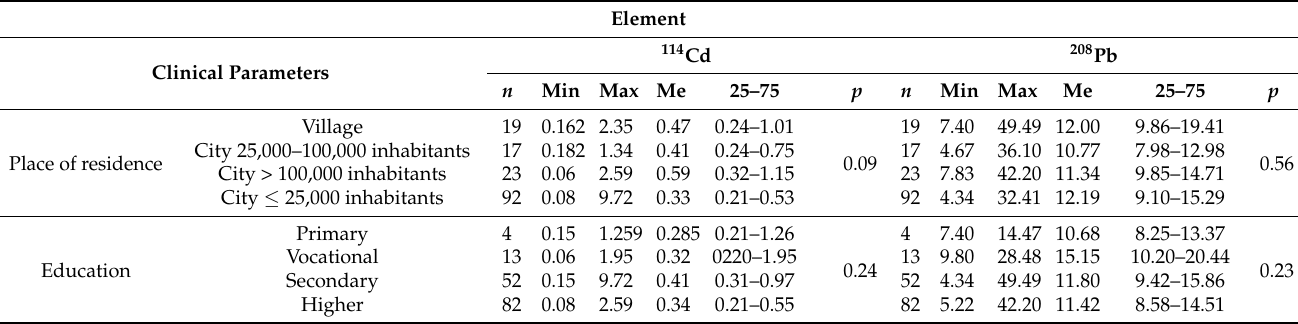
Table 5. Relationships between sociodemographic data and the levels of the tested elements.